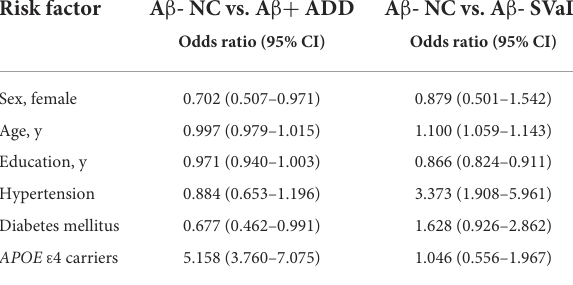
TABLE 2 Odds ratios of risk factors for ADD and